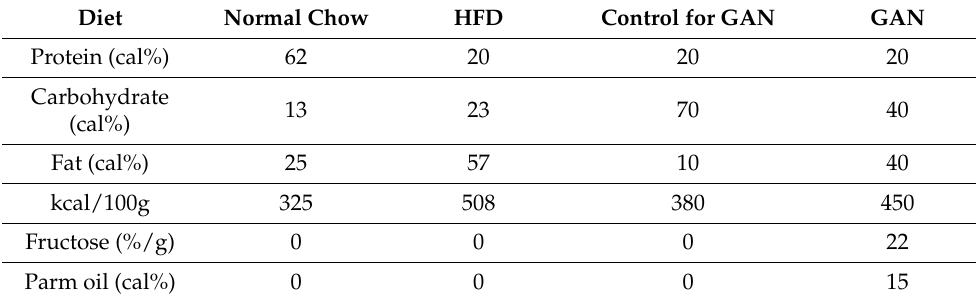
Table 2. Composition of diets used in the